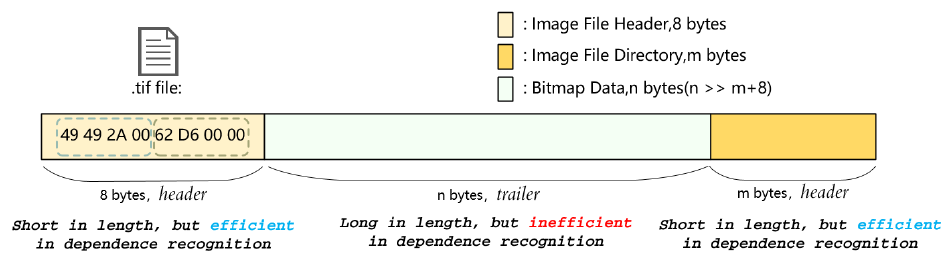
Figure 4. Example of I2S misses caused by colorization on invalid fields.